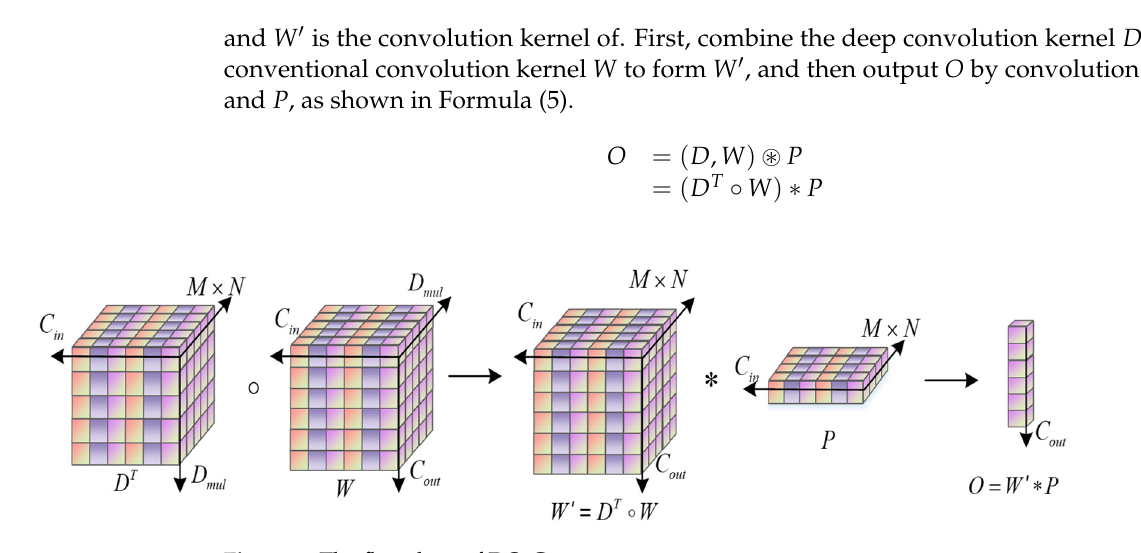
Figure 2. The flowchart of DO-Conv.